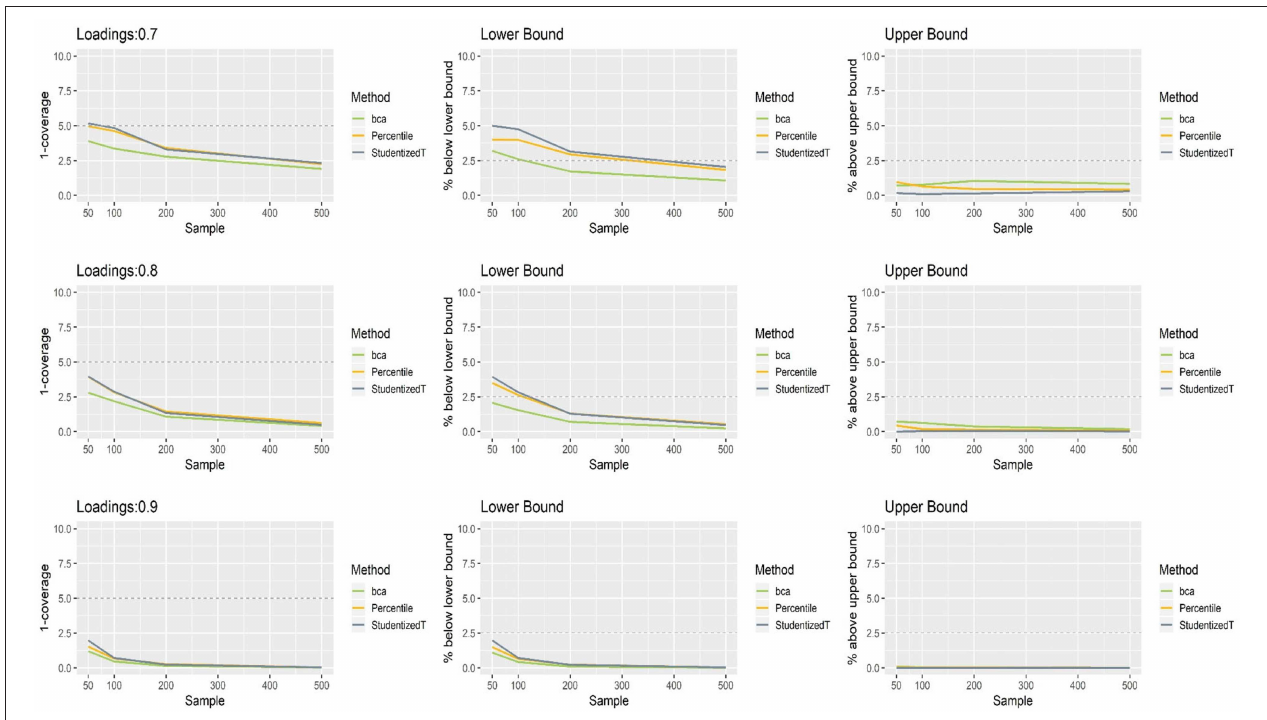
FIGURE 3 | The coverage and balance of percentile, bias-corrected and accelerated bootstrap (BCa), and Student’s t 95% confidence intervals (CIs) of 0.7, 0.8, and 0.9 loadings for non-normally distributed indicators.